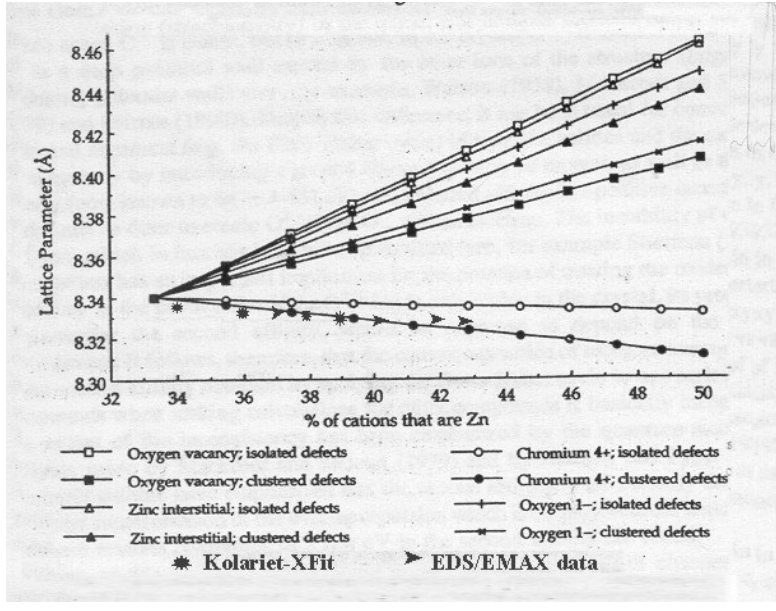
Fig. 3 Predicted spinel lattice parameters due zinc excess presence [8] shown together with the experimental data presented in this study (* Kolariet-Xfit; (cid:1) EDS/EMAX) The same authors also used their description of the interactions between ions during